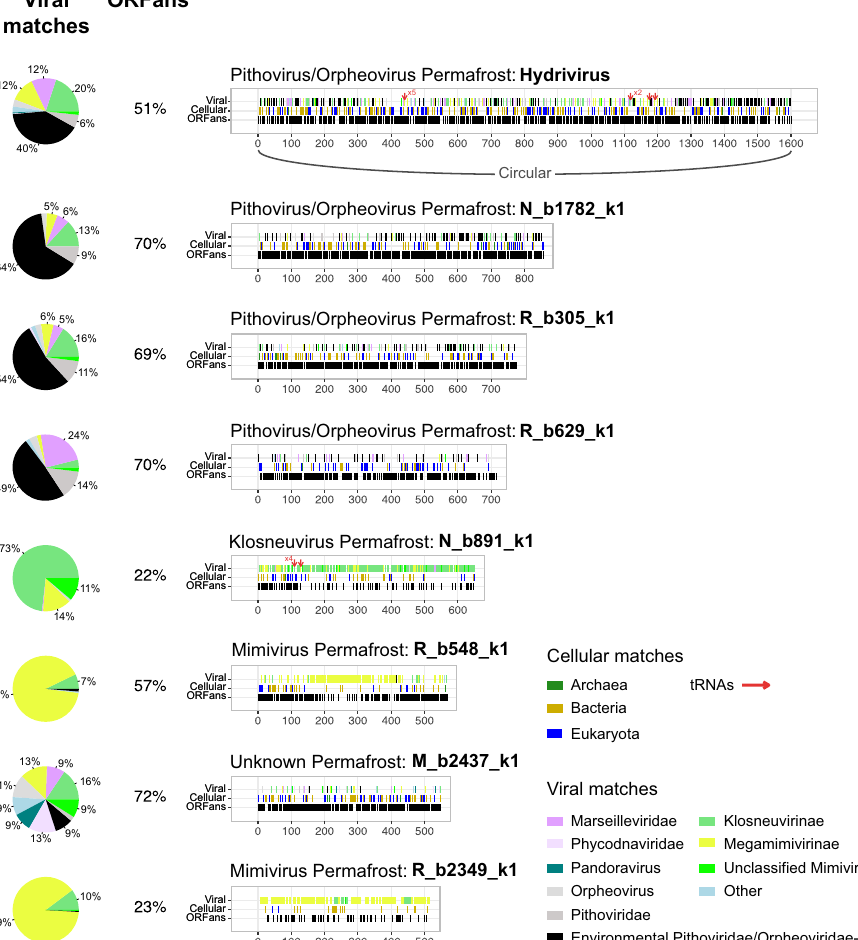
Fig. 4 | Gene content ofthe large genomes recovered from ancient permafrost samples. For each genome, the position of ORFans (ORFs with no match in the nr database),cellularandviralmatchesarerecordedalongthegenome.Thepositions of tRNAs are also shown as red arrows. The pie charts present the proportion and taxonomy of viral matches with slices ≥ 5% labeled. Groups that matchless than5%